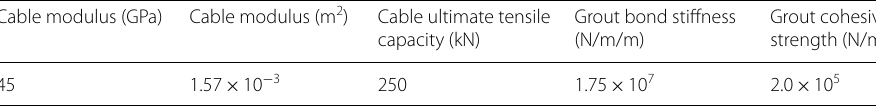
Table 7 Parameters used for modelling the cable bolts Cable modulus (GPa)